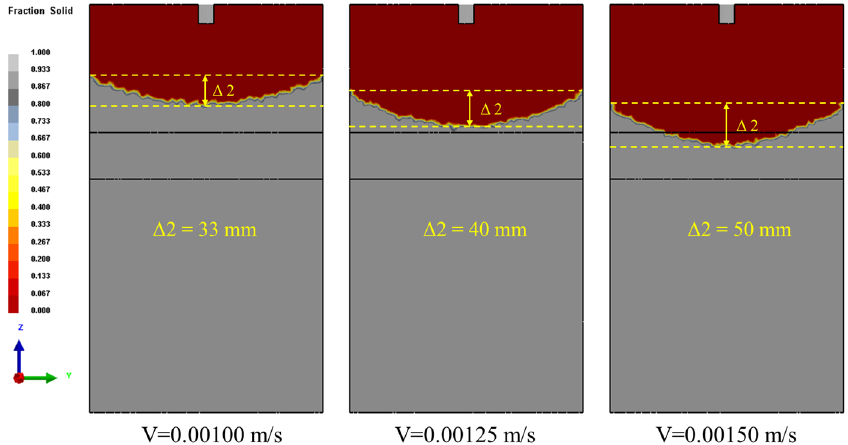
Figure 13. The shape and depth of Liquid sump with different casting speeds.